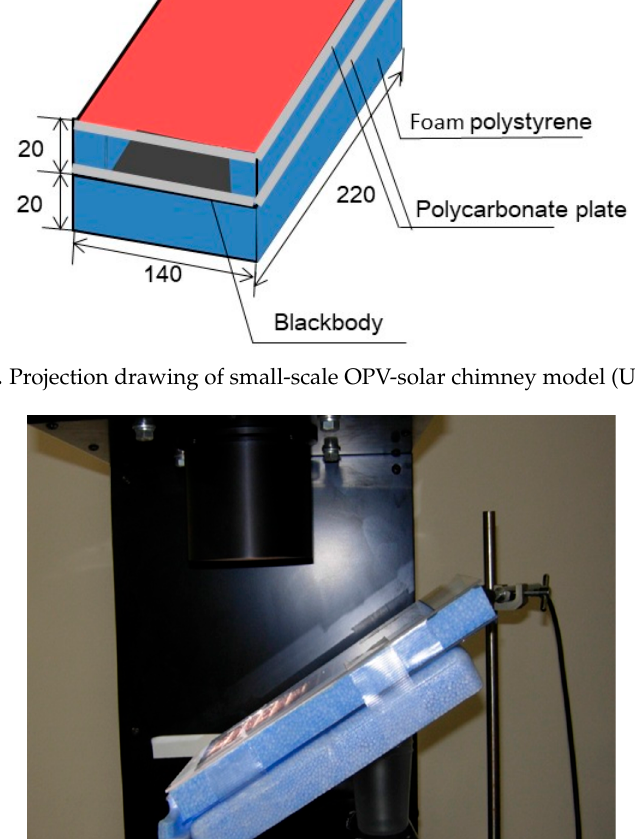
Figure 2. Exposure of OPV-solar chimney to solar spectrum light source.